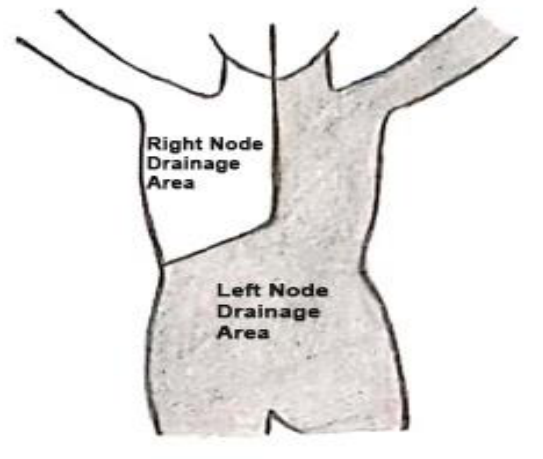
Figure 2. Right and left supraclavicular lymph nodes drainage